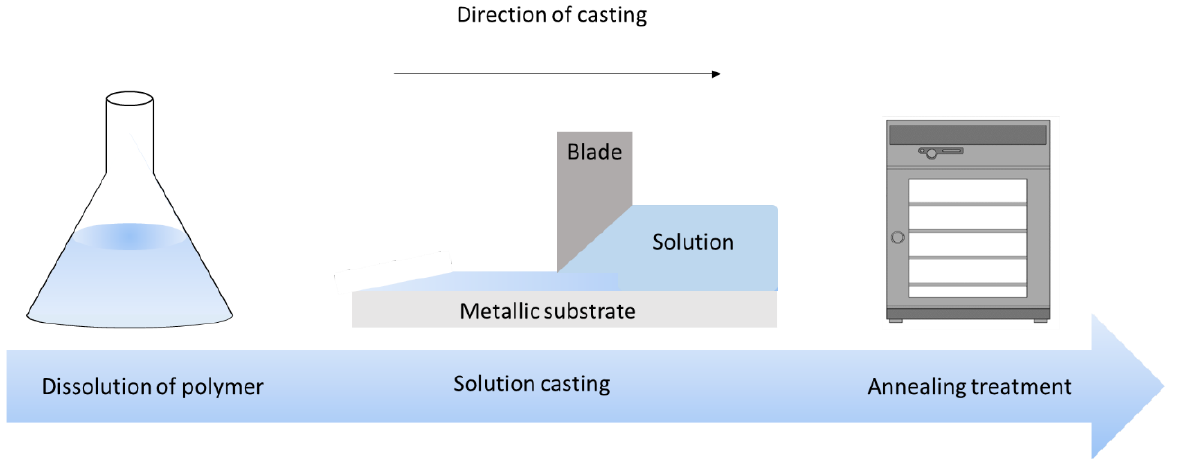
Figure 5. Sample preparation.